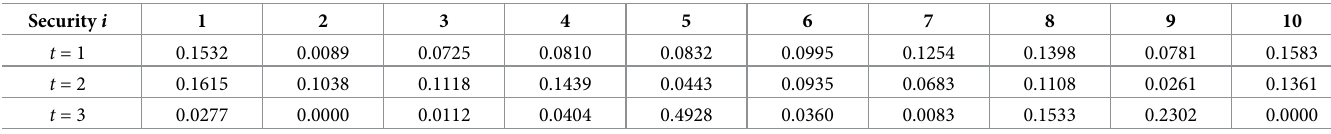
Table 2. Proportion of each security in the optimal